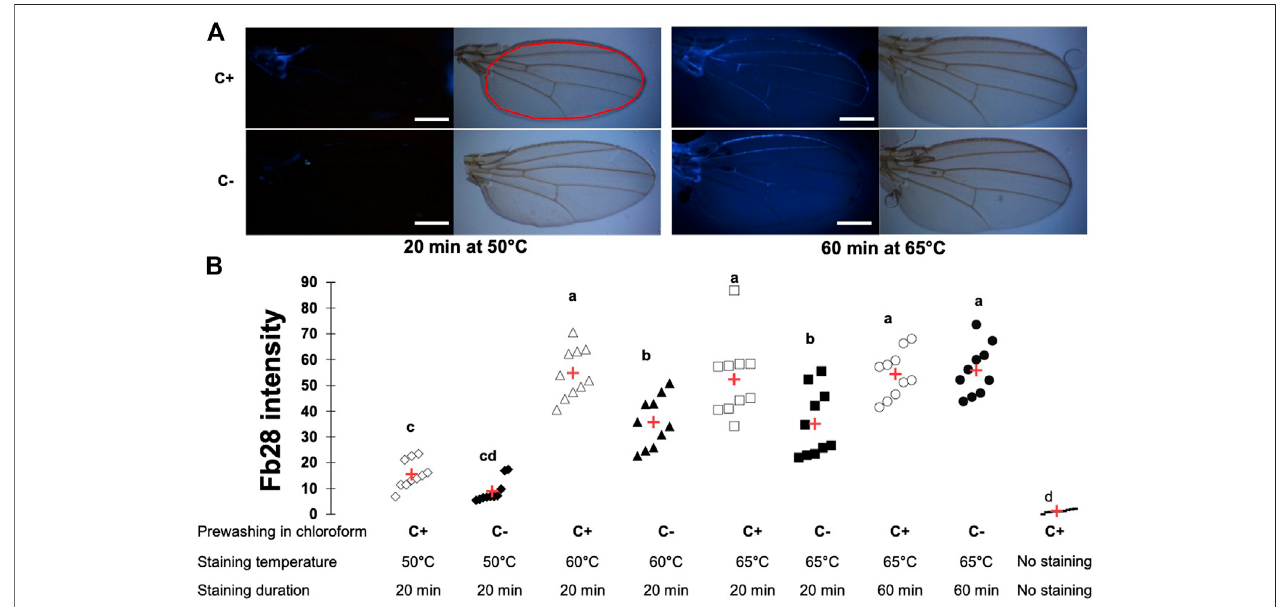
FIGURE1| FB28stainingofthewhole Drosophila wingrequireshightemperatureanddurationtobepenetration-independent. (A) Picturesfromwingsof48 h-old control female fl ies ( w1118 ) stained with FB28 at 50 ° or 65 ° C during 20 min or 60 min. Upper pictures were taken in bright fi eld. Lower pictures were taken with DAPI fi lter. To remove epicuticular hydrocarbons, fl ies were prewashed with chloroform (C+) or washed with PBS as a control (C-). Red line in the white light picture (on the right) indicates the zone used for quanti fi cation. Scale bars = 0.3 mm (B) FB28 intensity quanti fi cation in the whole wing excluding longitudinal veins. Data are representedasscattergramsshowingalldatapointswiththemean(redcrosses).C+andC-individualsarerepresentedwithemptyandblack fi lledmarkersrespectively. Different marker shapes indicate different temperatures. Different letters indicate statistically signi fi cant differences (one-way Kruskall-Wallis test followed by a Conover- Iman procedure, p -value < 0.001). n = 10 in each